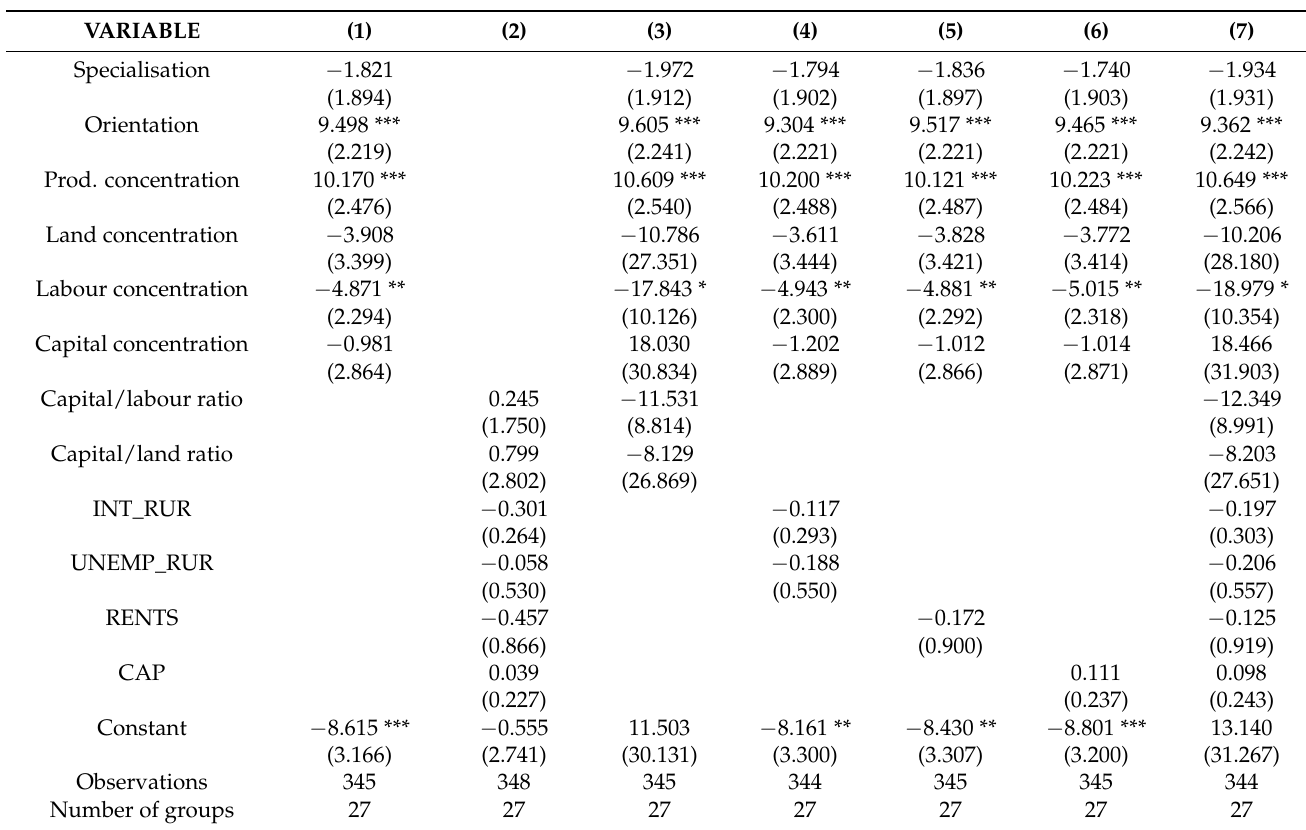
Table 2. Results of estimations (dependent variable is the SI process: 1-SI occurred, 0-SI did not